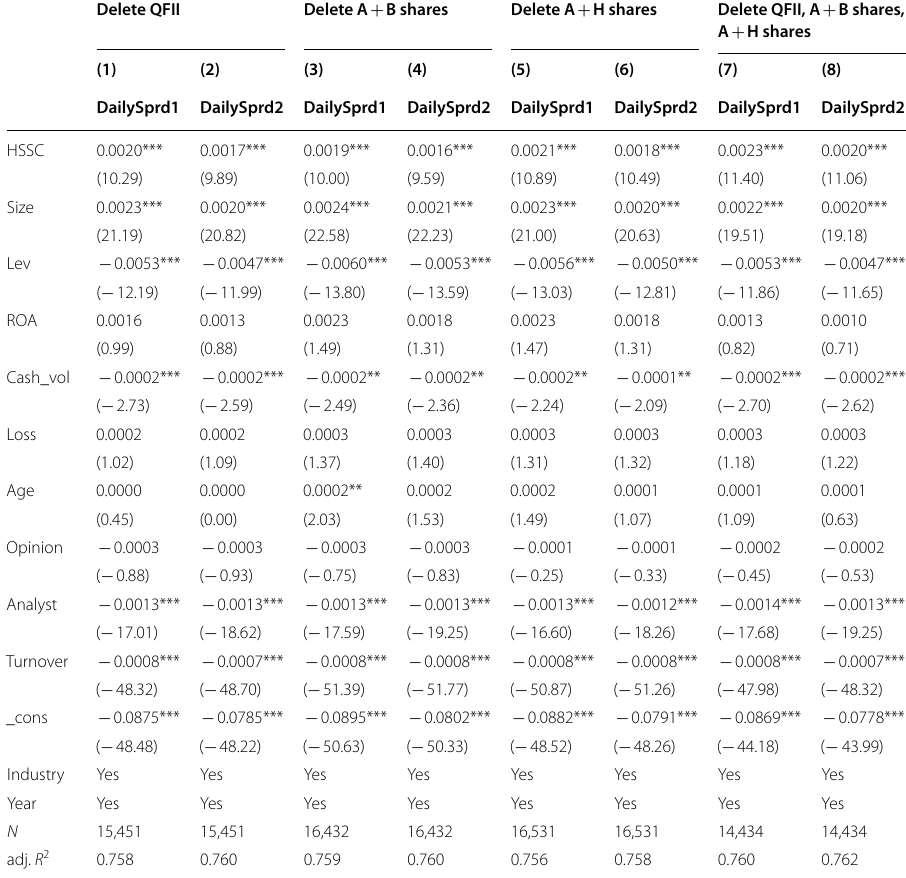
Table 11 Robustness checks: different sample range Delete QFII Delete A